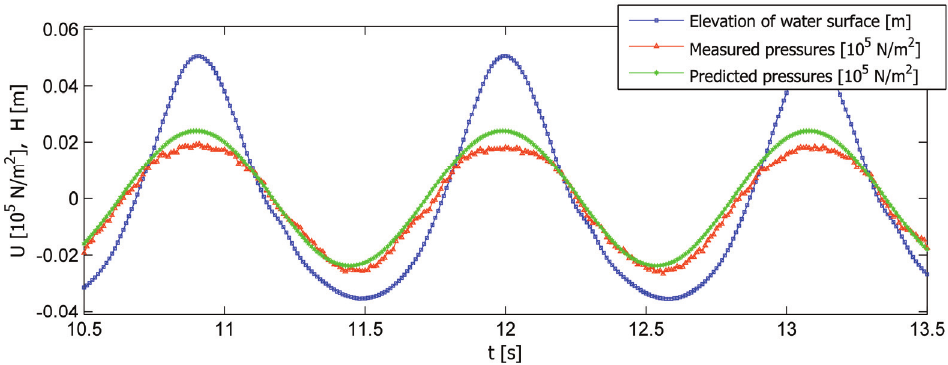
Fig. 4. Measured and predicted wave-induced pressures at the mudline